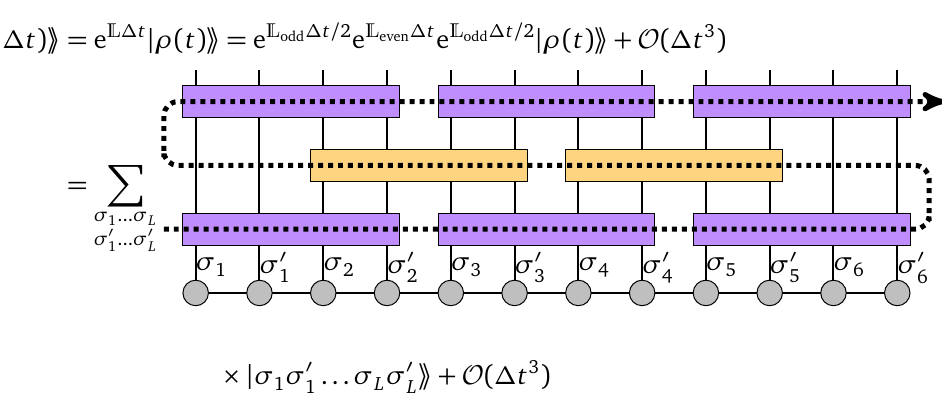
Figure 2: Dissipative evolution of the purified density matrix in MPS form by a single time step ∆ t using a second order Suzuki-Trotter decomposition for the evolution operator represented by a consecutive application of four-site gates. The two colors mark the affiliation to one of the two parts of the Lindbladian, i.e. either L L , and the arrow indicates the order of even